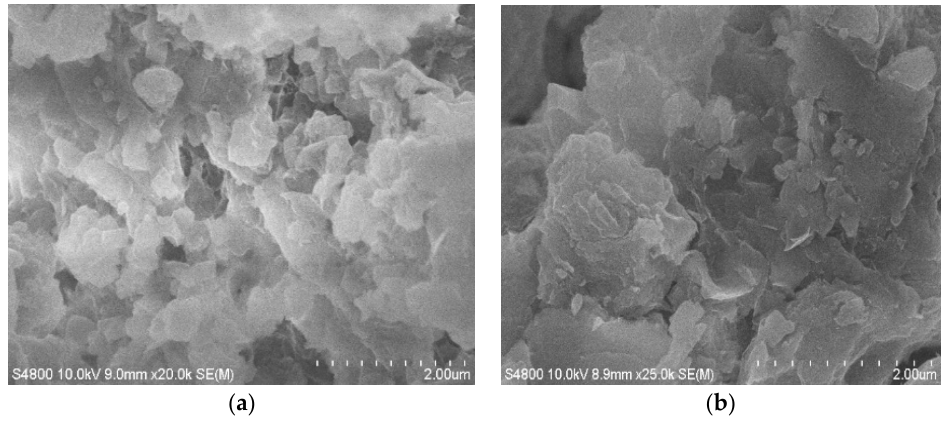
Figure 18. Scanning Electron Microscope (SEM) images of: ( a ) Co(II) ‐ loaded LMT; and ( b ) recovered LMT.